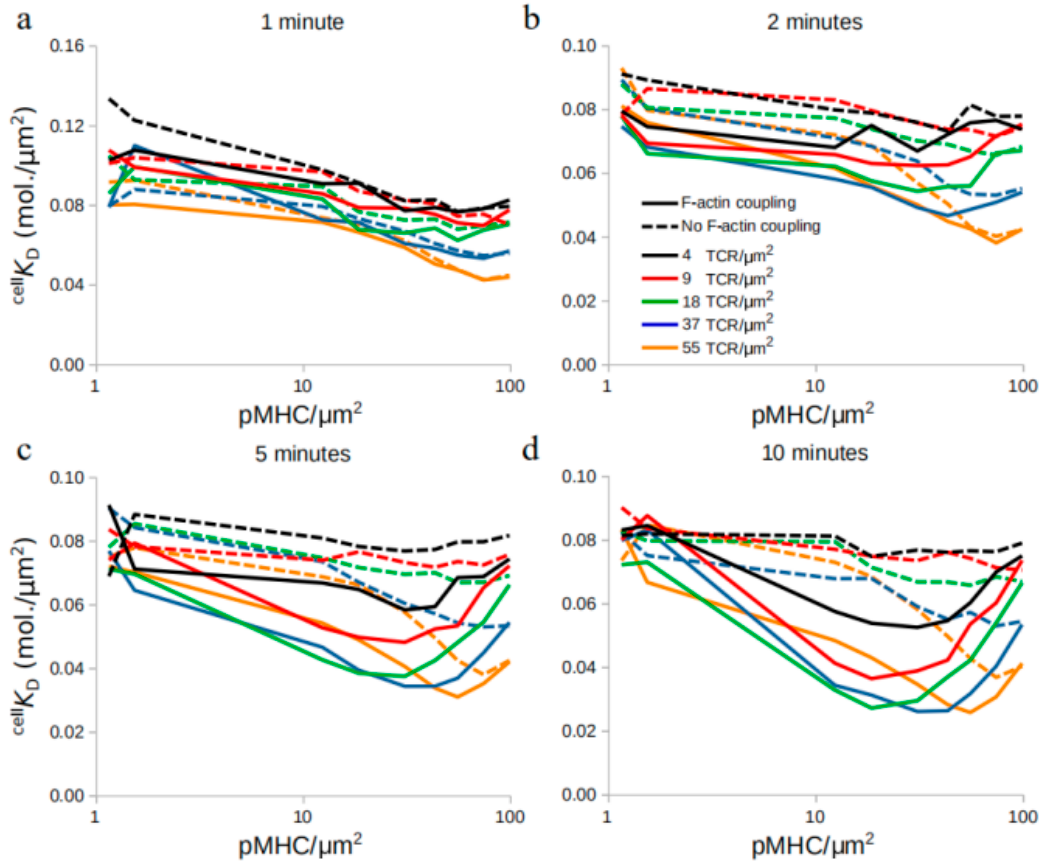
Figure 4. Time evolution of cell K D during TCR and pMHC titration in the presence (solid lines) or absence (dashed lines) of F-actin centripetal transport at 1, 2, 5, and 10 min, respectively ( a – d ).